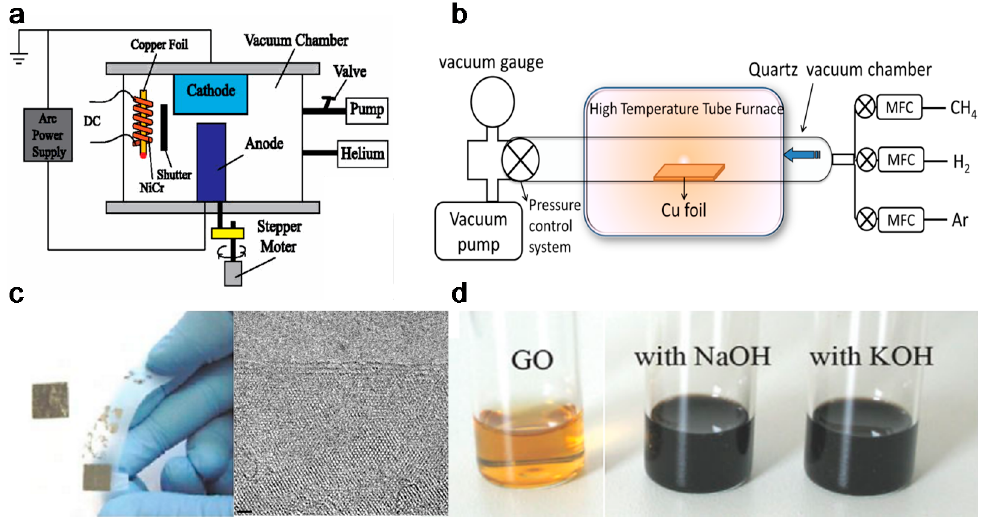
Figure 2. Graphene top-down synthesis methods. Schematic of ( a ) arc discharge [75] and ( b )